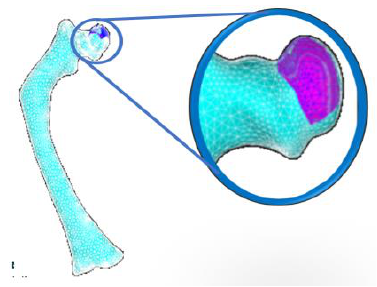
Figure 11. Force applied to the femur proximal epiphysis with a value of 431.64 N.